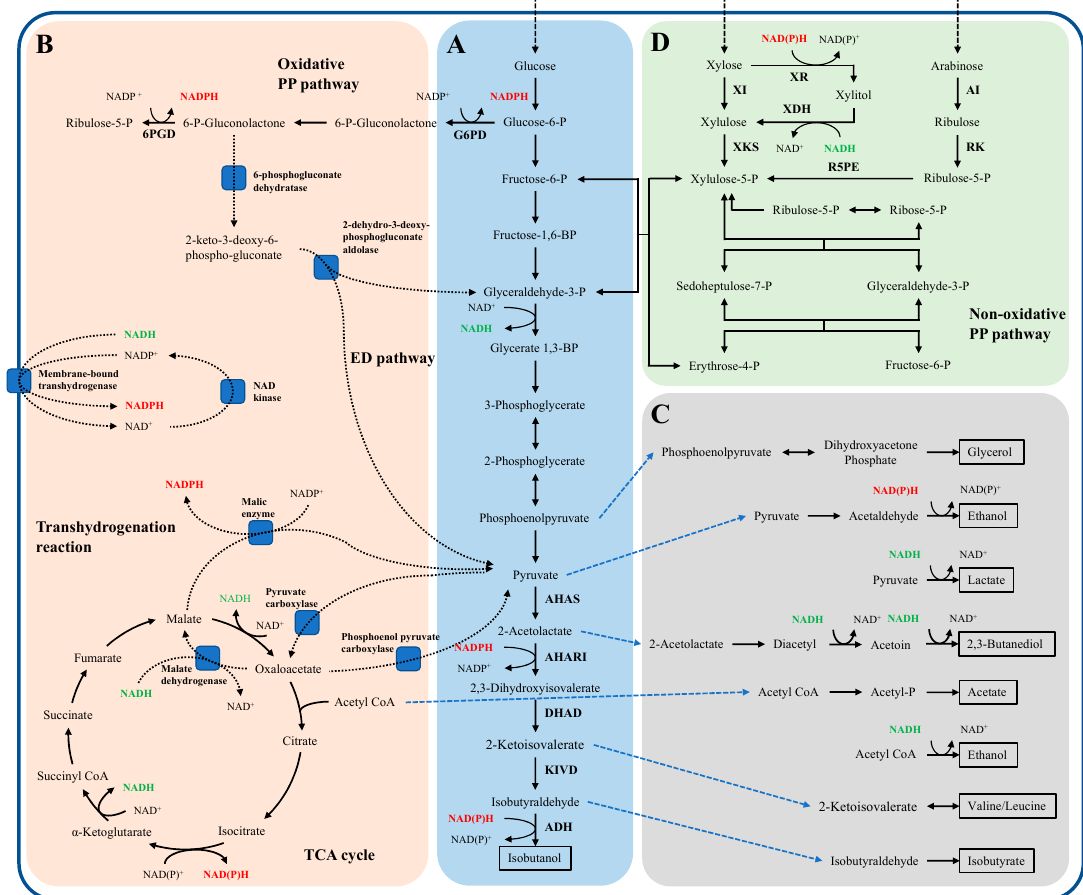
Figure 1. Schematic diagram of microorganism isobutanol synthesis pathways. Part ( A ) shows the general pathways of isobutanol biosynthesis; Part ( B ) shows a partial cofactor balancing strategy for successful optimization of isobutanol synthesis; Part ( C ) shows the common by-product synthesis pathways of isobutanol synthesis; and Part ( D ) shows the sugar metabolism pathway using non-glucose fermentation to produce isobutanol. The dashed line indicates the source of the precursor substance for the byproduct; AHAS: Acetolactate synthase; AHARI: Acetohydroxyacid reductoisomerase; DHAD: Dihydroxyacid dehydratase; KIVD: Keto acid decarboxylase; ADH: Alcohol dehydrogenase; G6PD: Glucose-6-phosphate dehydrogenase; 6PGD: 6-phosphogluconate dehydrogenase; XR: Xylose reductase; XDH: Xylitol dehydrogenase; XI: Xylose isomerase; XKS: